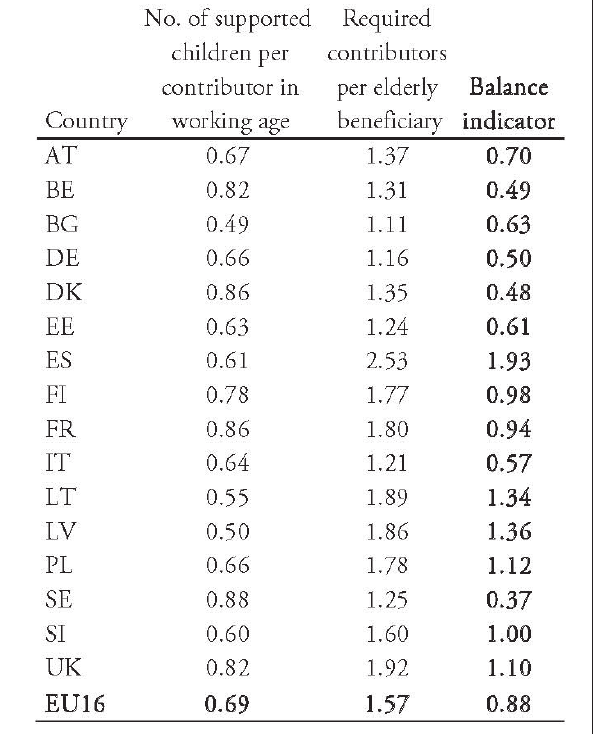
Table 3: The generational balance of